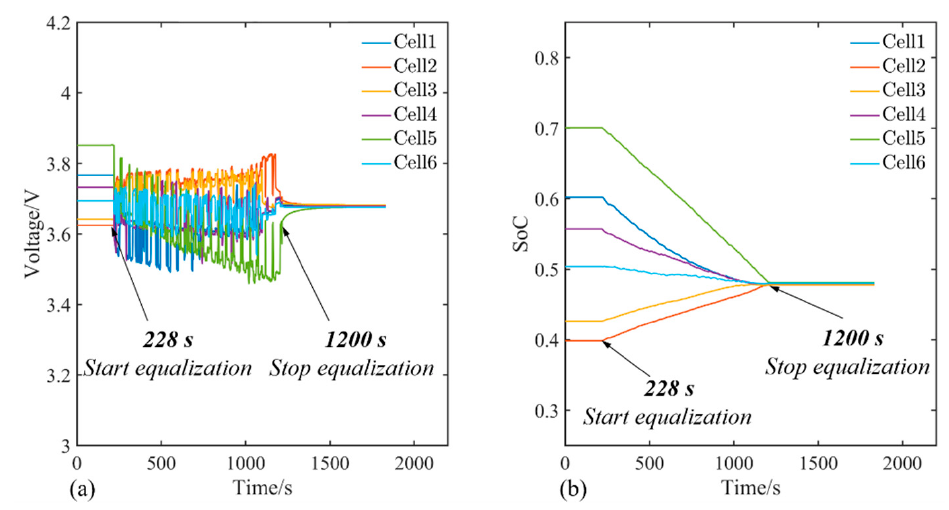
Figure 11. Equalization experiment based on VSSGPC: ( a ) Voltage; ( b ) SoC.